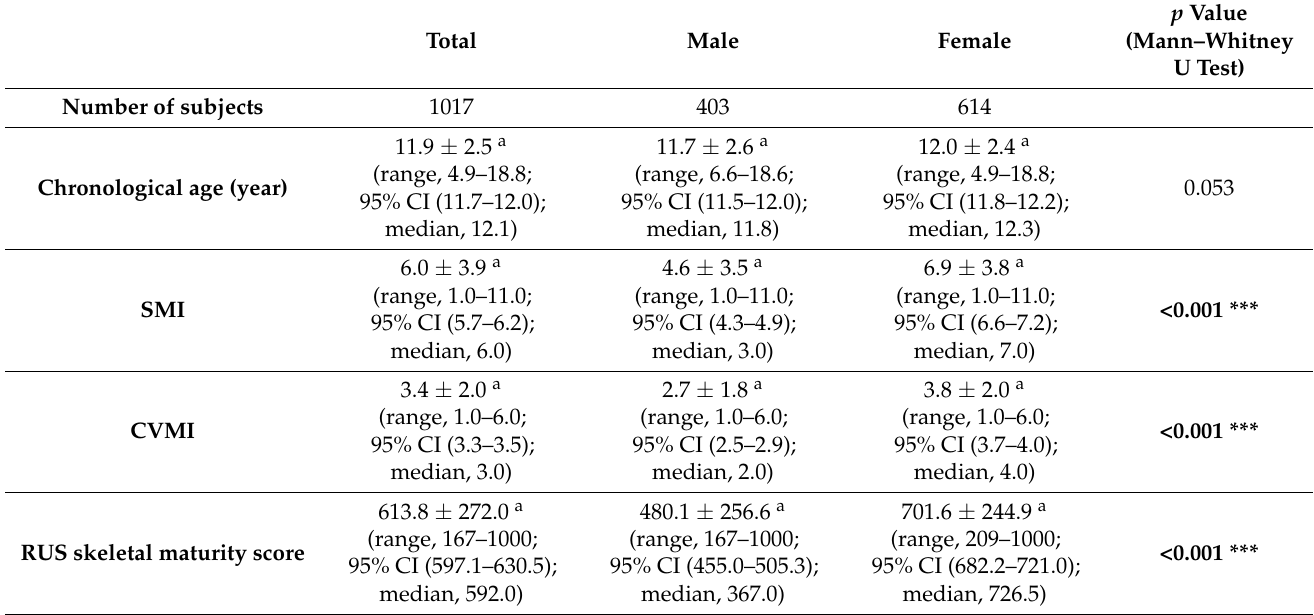
Table 1. Participant